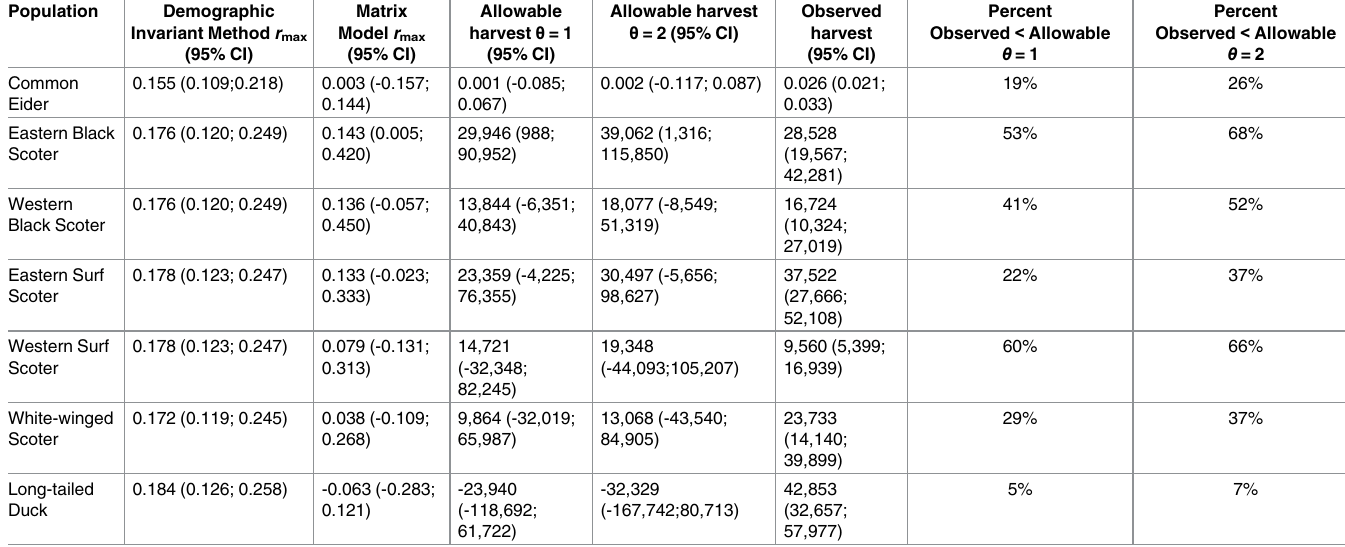
Table 2. Median (and 95% credible intervals) of simulation-derived probability distributions for theoretical maximum values of r max derived using the Demographic Invariant Method, population-specific values of r max derived using a projection matrix, allowable total harvest(or harvestrate for eider) derived from population-specific r max values at θ = 1 and θ = 2 to bracketthe functional form of density dependence, observed total harvest (harvestrate for eider) including sport and subsistence harvestadjusted for crippling loss, and percent of simulations where observed harvest was (cid:20) allowable harvestwhen θ = 1 and θ = 2 for seven populations of North American sea